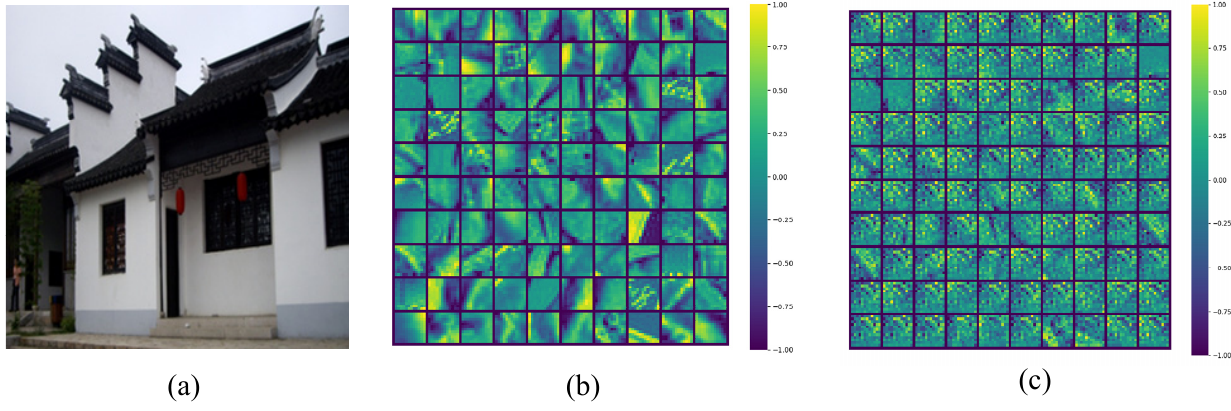
Figure 7. Feature map transformation process: ( a ) an original image; ( b ) feature maps presented consecutively in the output of the generator network; ( c ) feature maps presented consecutively in the discriminator.